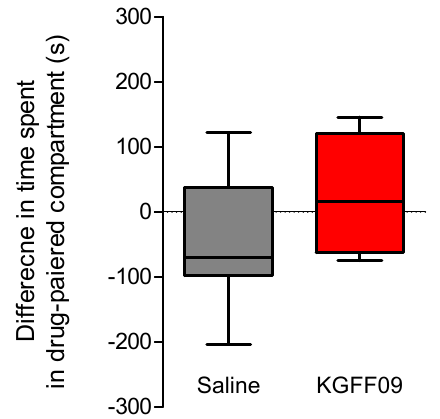
Figure 4. Rewarding effects of KGFF09 in the CPP test in mice after s.c. administration. Following determination of initial preconditioning preferences, mice were place-conditioned daily for 4 days with KGFF09 (7.4 µ mol/kg) or saline. Mean differences in time spent on the drug-paired side ± SEM are presented ( n = 8 mice per group).